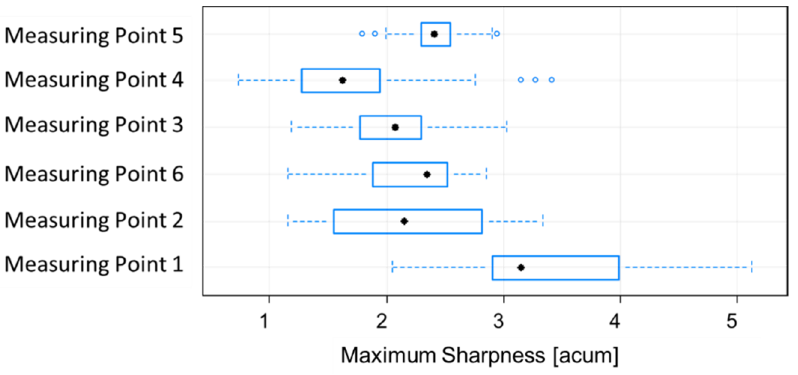
Figure 13. Maximum Sharpness in (acum) at each measuring point for all passing tramways.